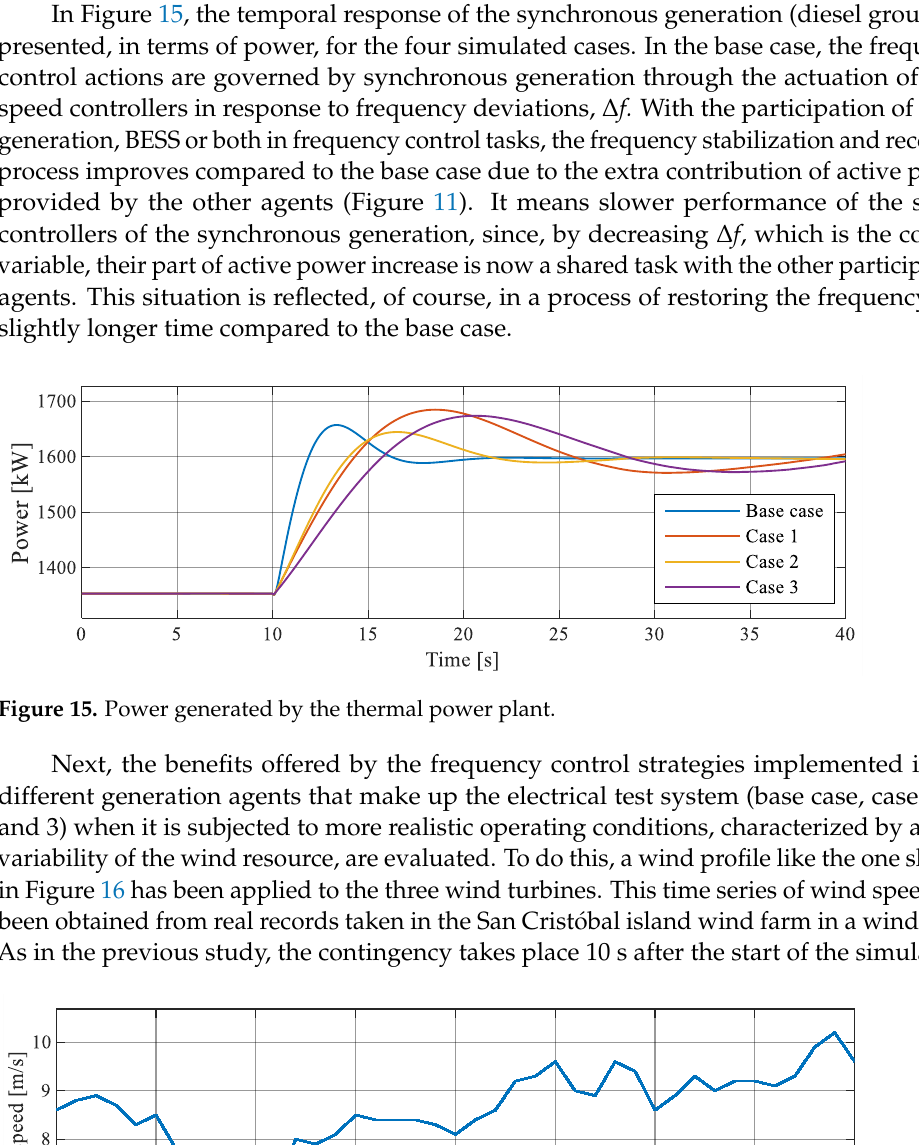
Figure 14. Active power deviation experienced by the BESS in a sub-frequency event.